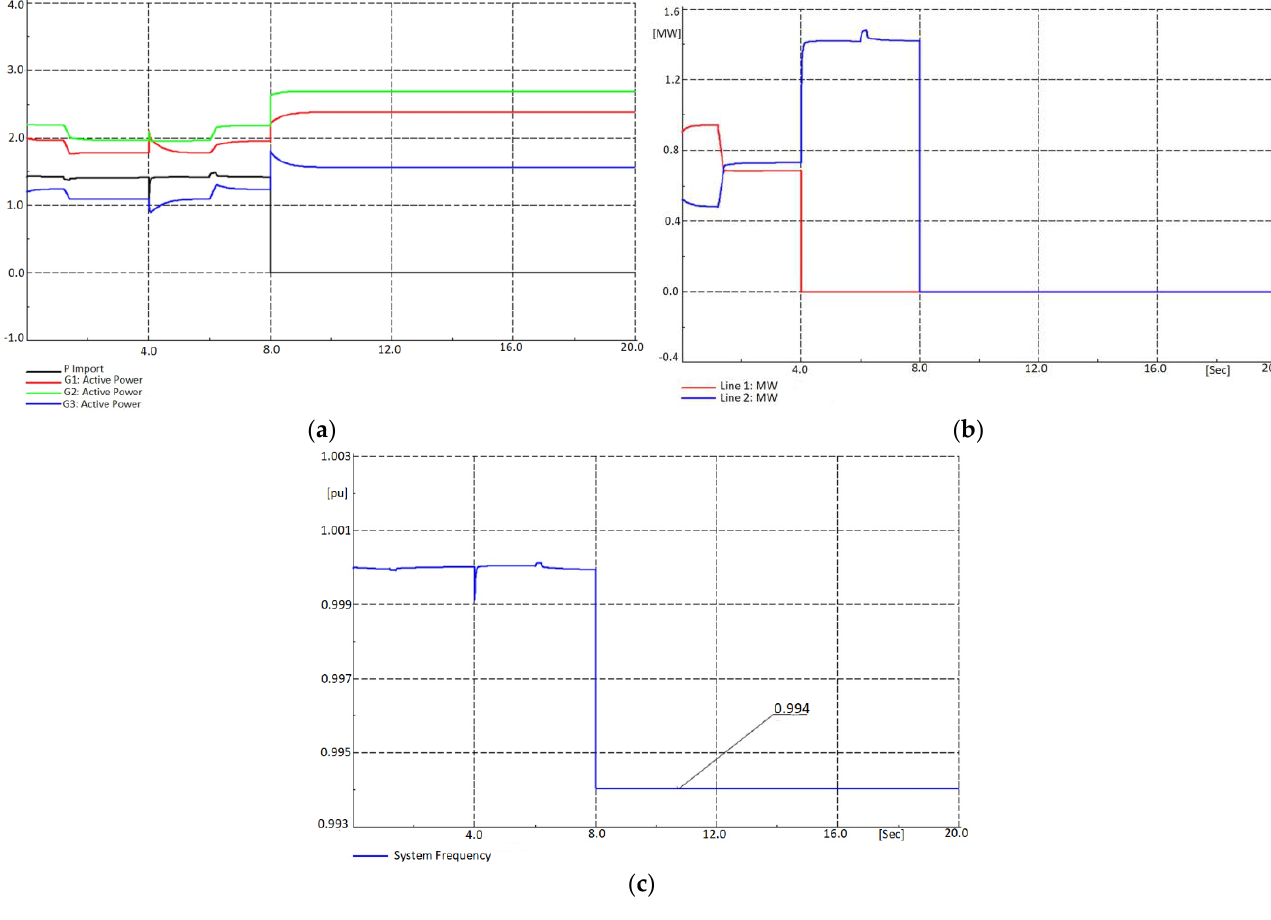
Figure 8. Simulation results of Case study-2. ( a ) Active Power of SG1, SG2 and SG3; ( b ) Active Power Flow on Line 1 and Line 2; ( c ) Frequency of Micro Grid.